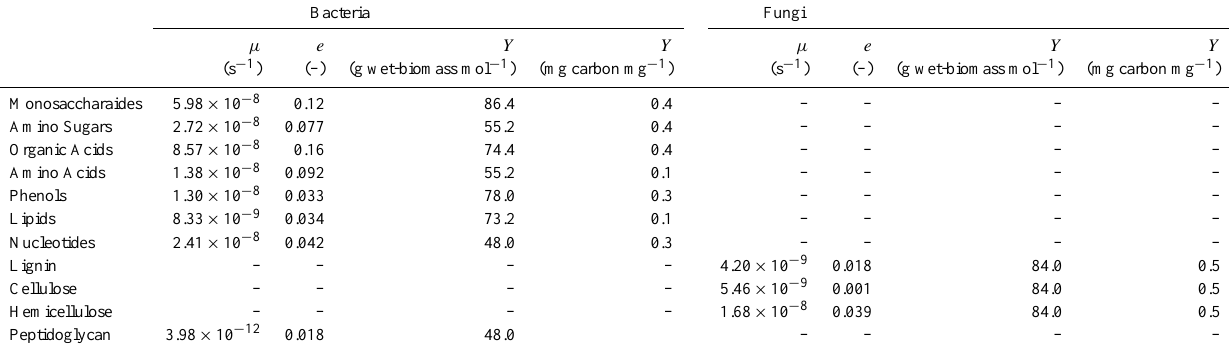
Table 2. Parameters defining decomposition of organic matter pools by bacteria and fungi for maximum specific consumption rate ( µ ), assimilation-to-respiration ratio ( α ), and yield